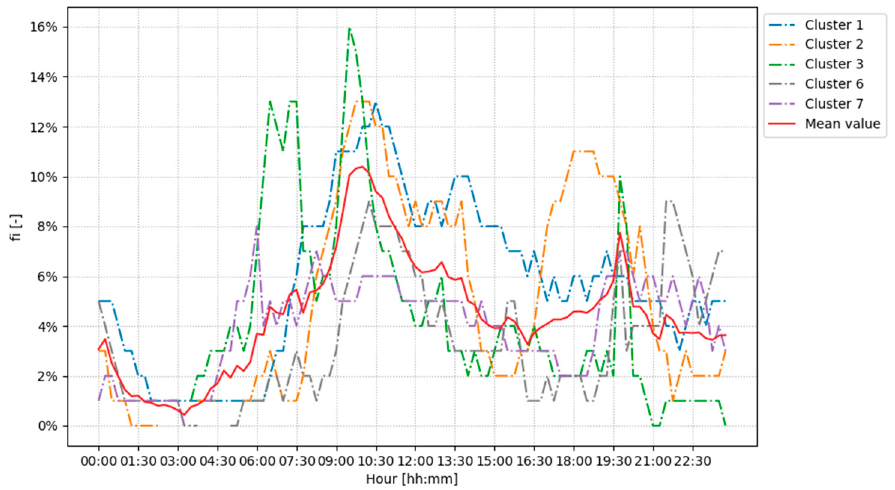
Figure 8. Daily usage probability: Washing machines.